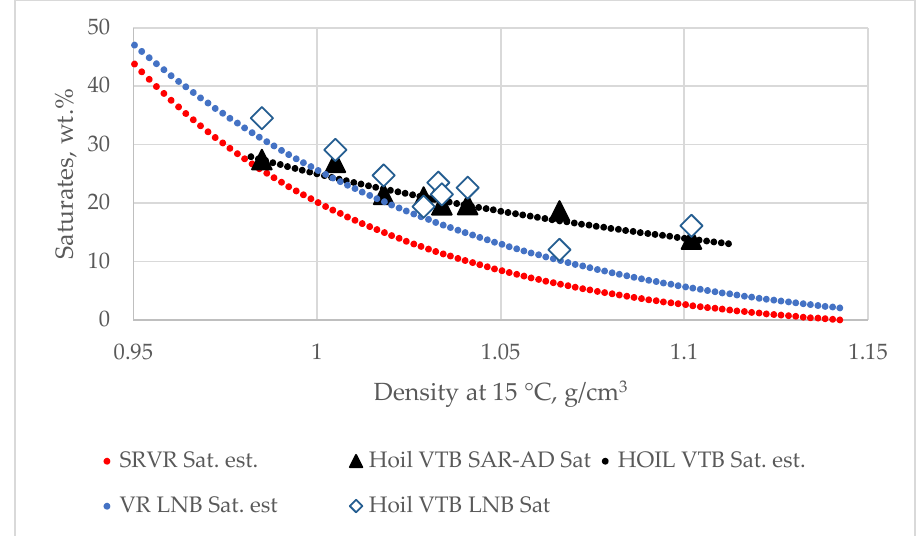
Figure 2. Relation of hydrocracked vacuum residue density to saturate content determined by SAR-AD TM and LNB SARA methods.